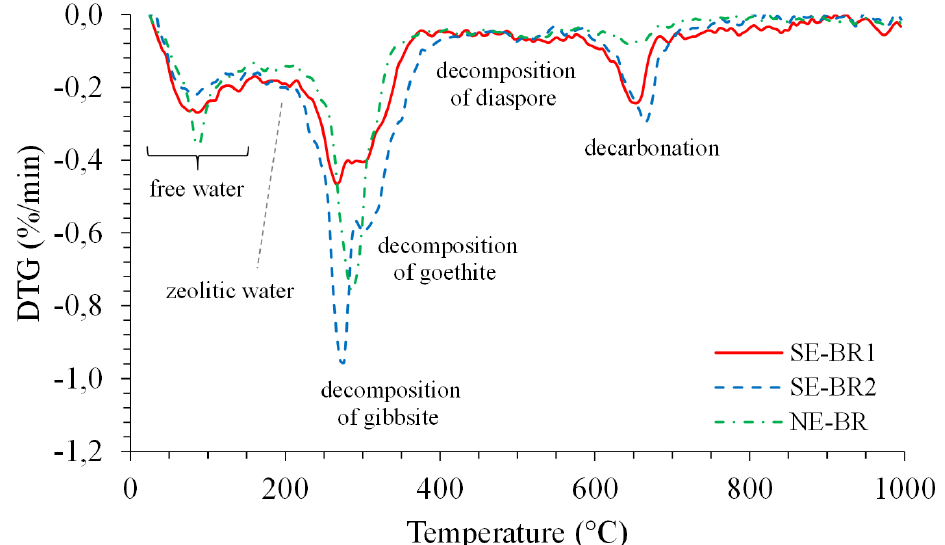
Figure 2 D erivative of mass loss (DTG results) of bauxite